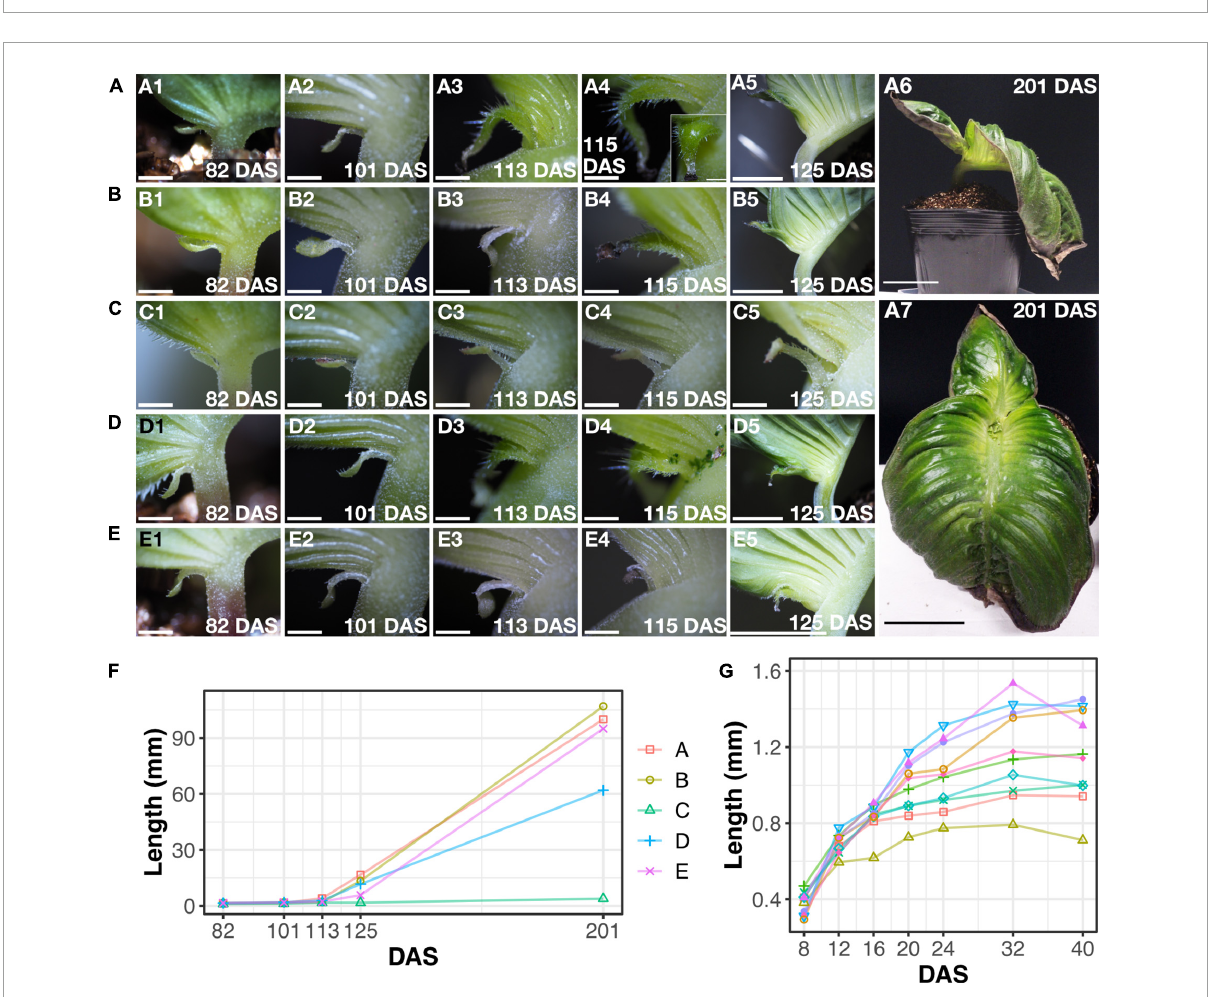
FIGURE4 Microcotyledons resume growth under laboratory conditions. (A–E) Five individuals, (A–E) at 82, 101, 113, 115, 125, and 201 [only for (A) ] DAS (1–6). The inset in (A4) is a view from the adaxial side of the microcotyledon. (A7) is the frontal view of the individual in (A6). (F) The length of the microcotyledons of each individual, (A–E) . (G) The length of microcotyledons in 10 additional individuals at 8–40 DAS. Bar = 1 mm in (1–4) in (A–E) and (C5), 1 cm in (5) in (A,B,D,E) , and 5 cm in (A6, A7).